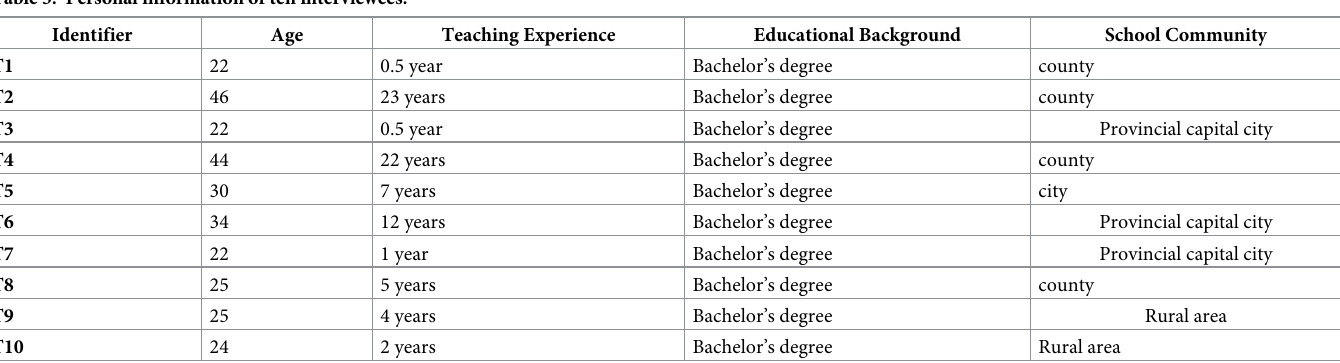
Table 3. Personal information of ten